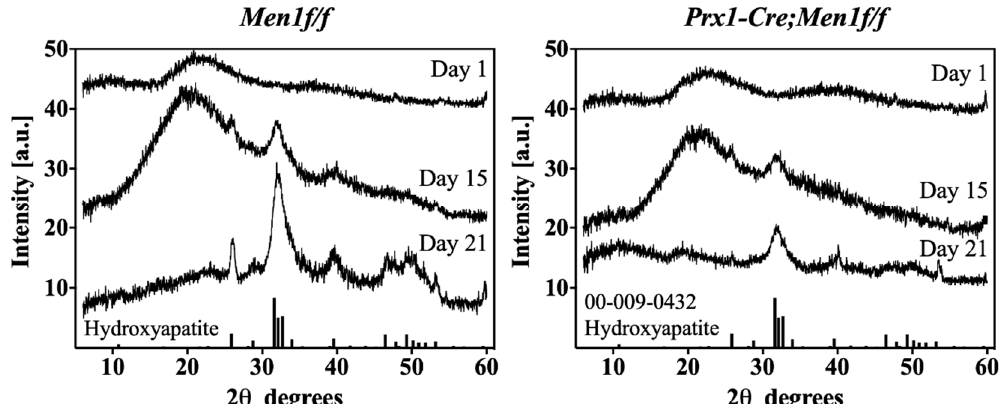
Figure 4. XRD diffractograms of cell-mediated matrix mineralization. Left and right diffractograms show time-dependent XRD diffractograms of 3D seeded calvarial osteoblasts from 6 month old Men1f/f and Prx1-Cre , Men1f/f , respectively, seeded in dense collagen gels up to day 21 in osteogenic differentiation medium. Both groups displayed a time-dependent amorphous-to-crystalline transition. Men1f/f seeded gels displayed higher intensity peaks relative to those of Prx-Cre, Men1f/f ( n =